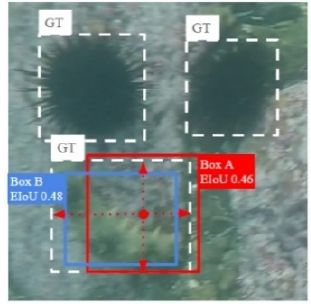
Figure 6. Example of